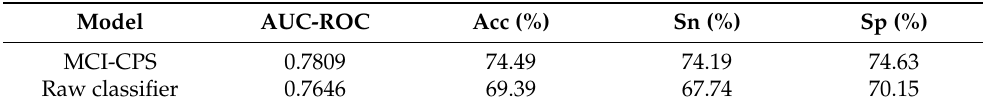
Table 2. Comparison of models for predicting conversion from MCI to AD between MCI-CPS and Raw classifier in ADNI-GO/2 as an independent test set.